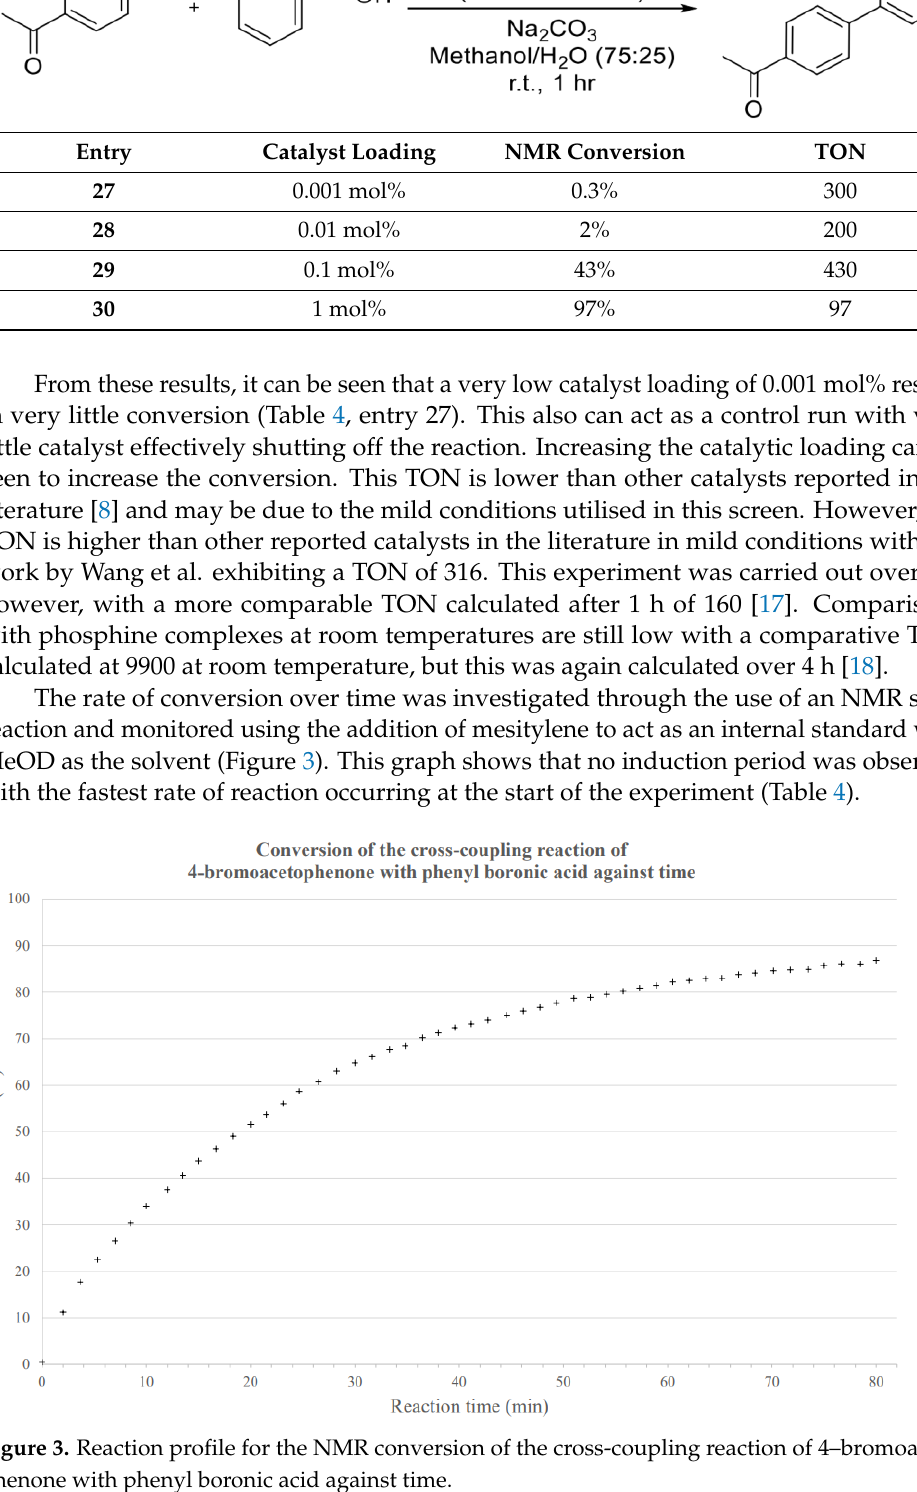
Figure 3. Reaction profile for the NMR conversion of the cross-coupling reaction of 4–bromoaceto- phenone with phenyl boronic acid against time.